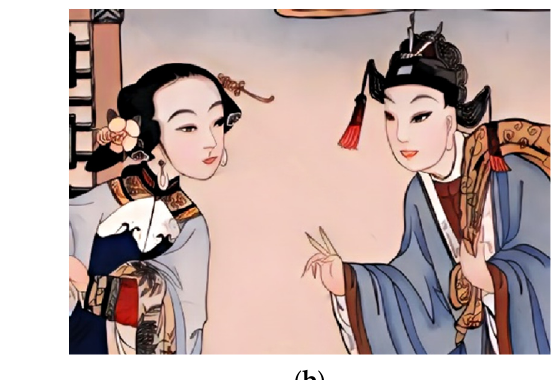
Figure 7. ( a ) is the original Yangliuqing New Year print; while ( b ) is the processed image.